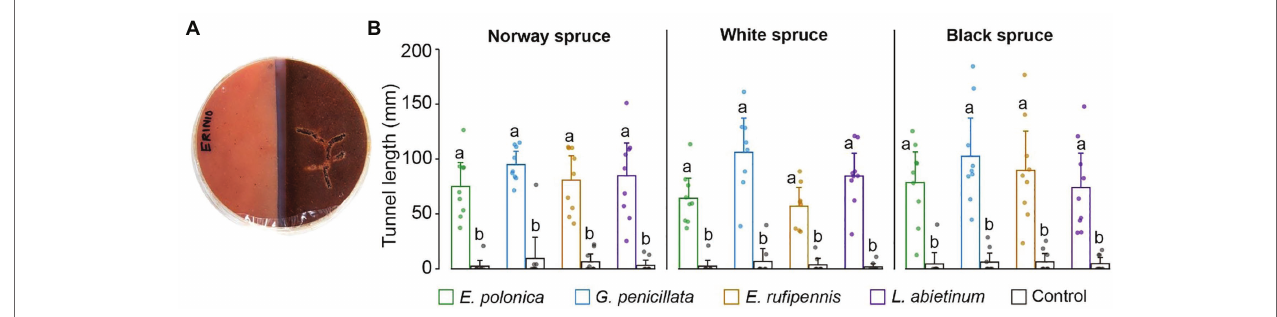
FIGURE 5 | (A) Bark beetle tunneling in single-species choice arenas containing semi-circles of bark agar medium made from Norway spruce, black spruce, or white spruce. The medium was either colonized by one of four fungal species 15 days earlier (right) or was un-colonized (left). (B) Beetle tunneling length in un- colonized bark agar (Control) and in bark agar colonized by different bluestain fungi 5 days after the beetles were introduced into the arenas. Bars show mean values with 95% CIs. Dots show individual replicates ( n = 9 individual trees per spruce species). Treatments with different letters (a, b) differed significantly (ANOVA and Tukey’s HSD test with p < 0.05). E, Endoconidiophora ; G, Grosmannia ; and L, Leptographium